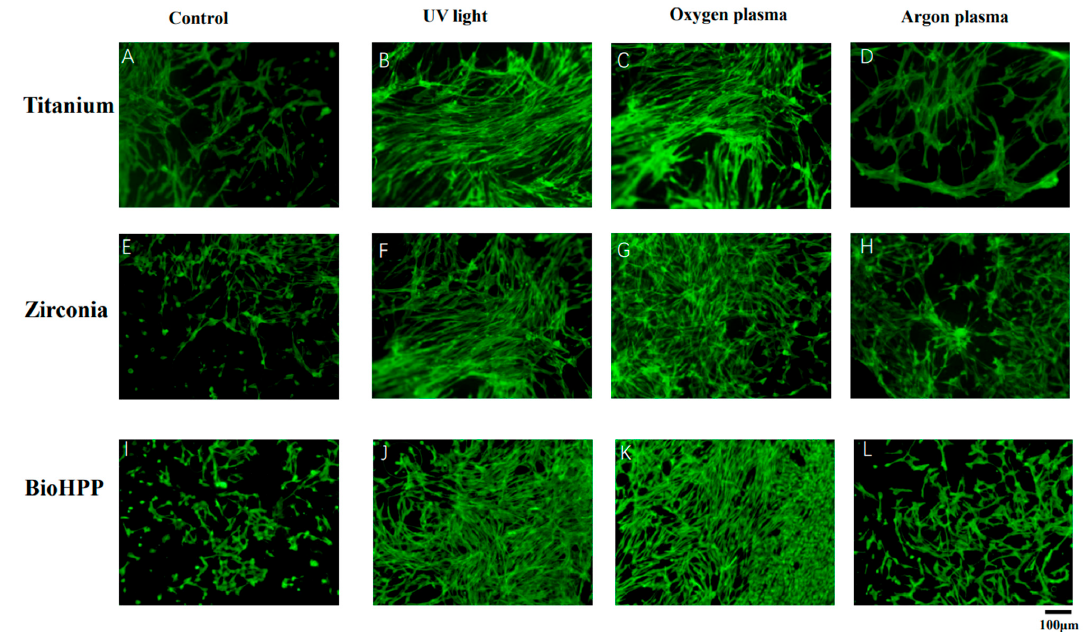
Figure 2. Cell attachment and morphology of osteoinductive DPSCs on different surface treated titanium, zirconia and BioHPP after 21 days. The attachment of osteoinductive cells at 21 days of culture was observed using fluorescence microscopy (20×). Adhesion of cells was weak and cells were loosely distributed on untreated surfaces of titanium, zirconia and BioHPP ( A , E , I ). Either UV light or NTP treatment resulted in stronger cell adhesion and dense distribution ( B – D , F – H , J – L ), whereas argon plasma treatment led only to sparse cell adhesion ( D , H , L ).